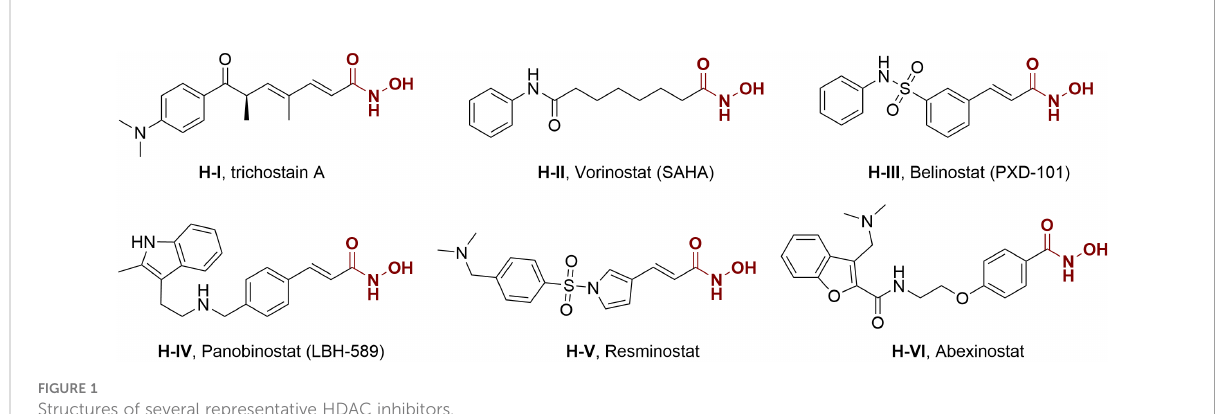
FIGURE 1 Structures of several representative HDAC